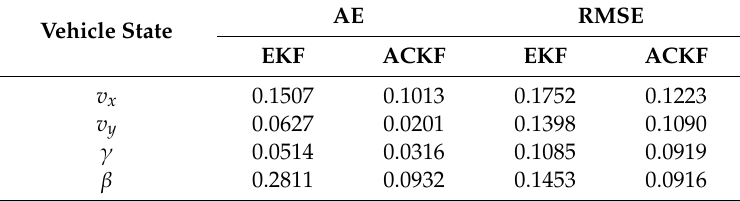
Figure 5. Comparison of estimation effects in fishhook maneuver: ( a ) Longitudinal vehicle speed; ( b ) lateral vehicle speed; ( c ) yaw rate; ( d ) sideslip angle. Table 3. Quantitative analysis of estimation effects in the fishhook maneuver.